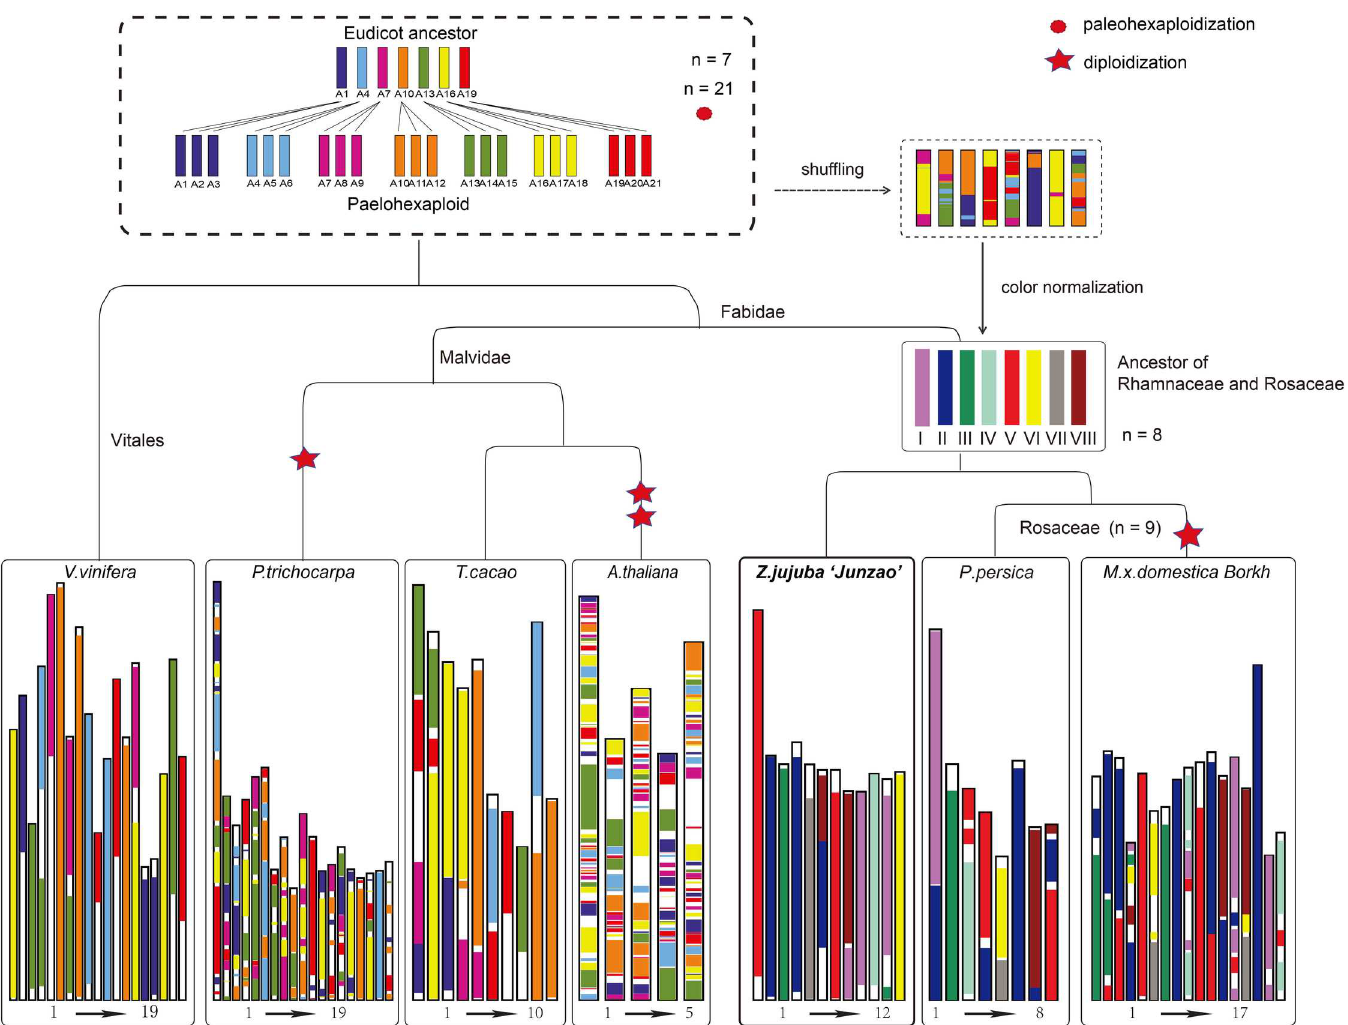
Fig 1. Evolutionary scenario of genome rearrangements from the ancestor of Rosales to jujube, peach and apple. In the top-right diagram,different colors in each chromosome represent the origin from the seven common ancestralchromosomes of eudicot, and the eight chromosomes filled with different colors represent putative paleo-chromosomes for the common ancestor of Rhamnaceaeand